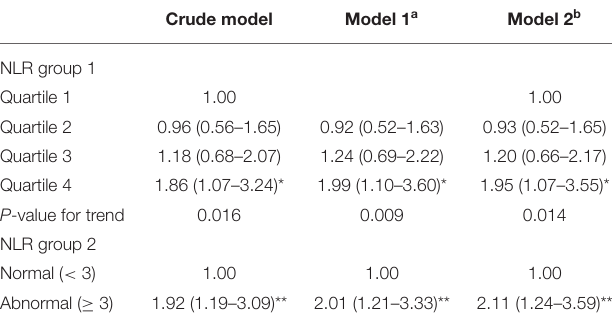
TABLE 4 | Prospective relationship between NLR and incidence of pre-frailty or frailty in robust ( n = 562) community-dwelling older adults of the CLHLS. Crude